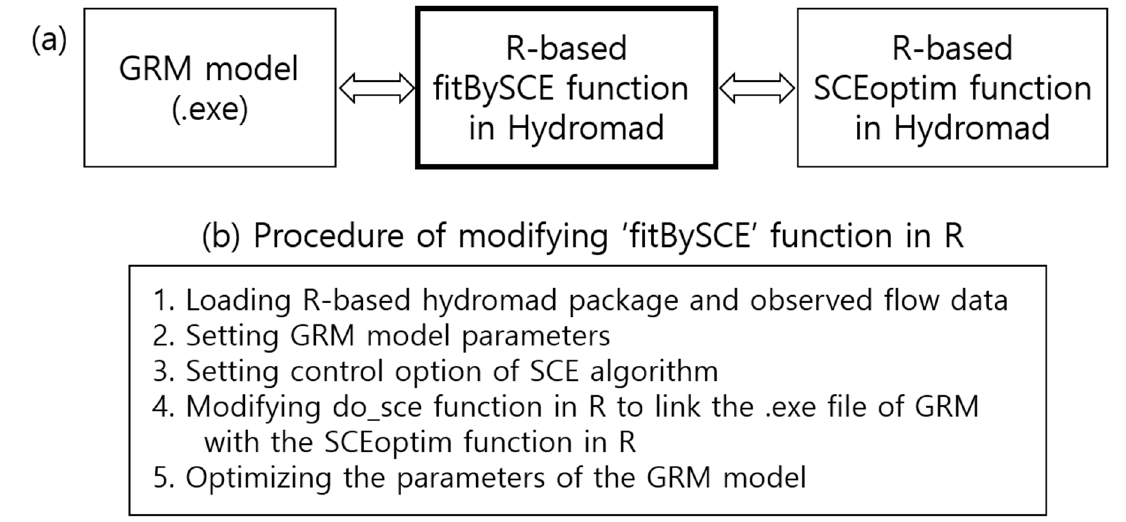
Figure 1. Conceptual diagram of the combination of the GRM and the SCE algorithm in R. ( a ) is the schematic of the combination of the GRM and the SCE algorithm provided in the hydromad package. ( b ) is a brief description of the procedure for modifying the link code in R.